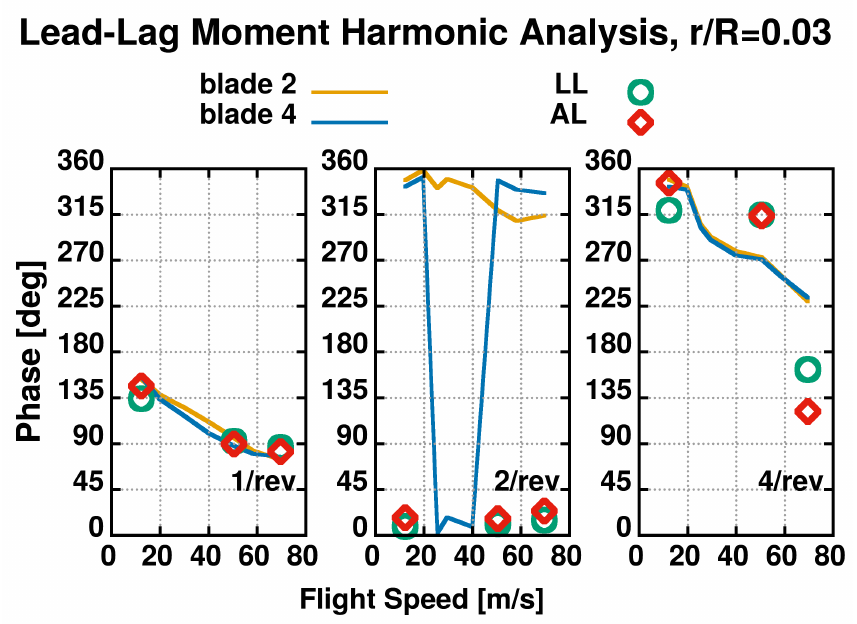
Figure 43. Harmonic analysis of Lead-Lag bending moment. Phase of frequencies with the highest energy